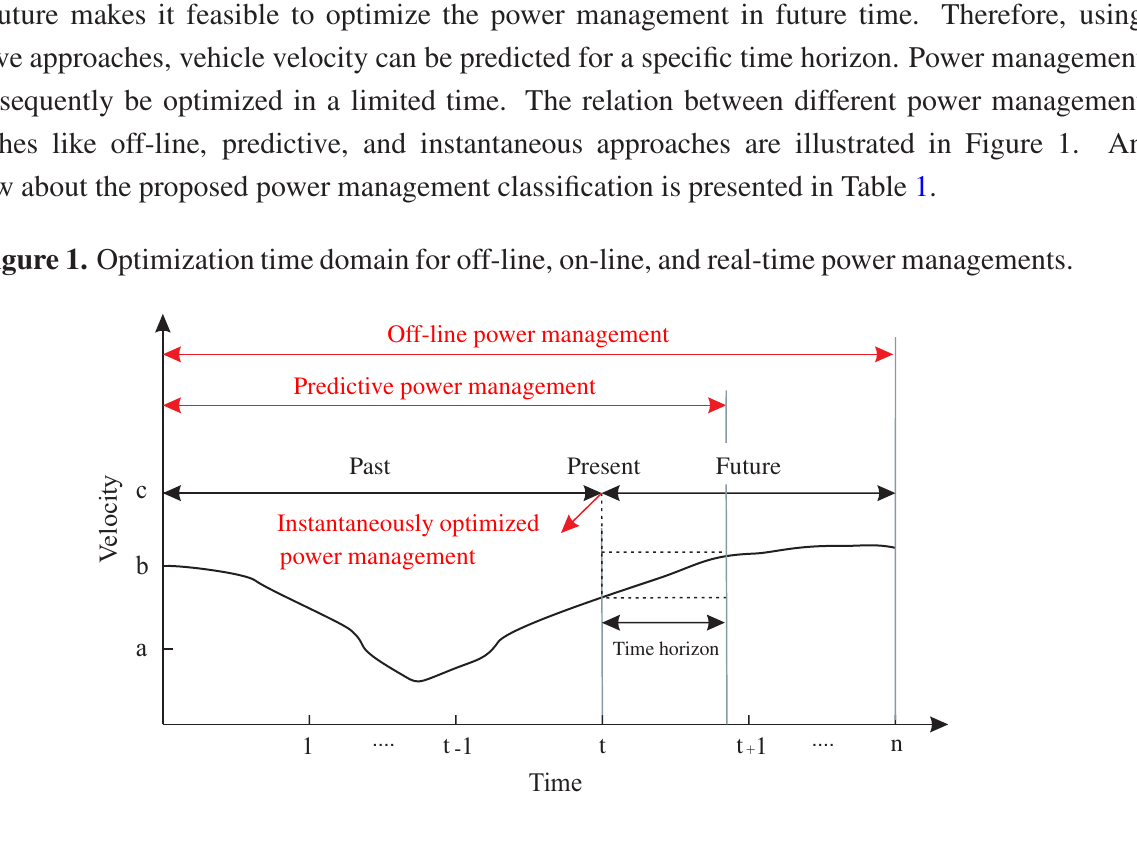
Table 1. Classification of power management